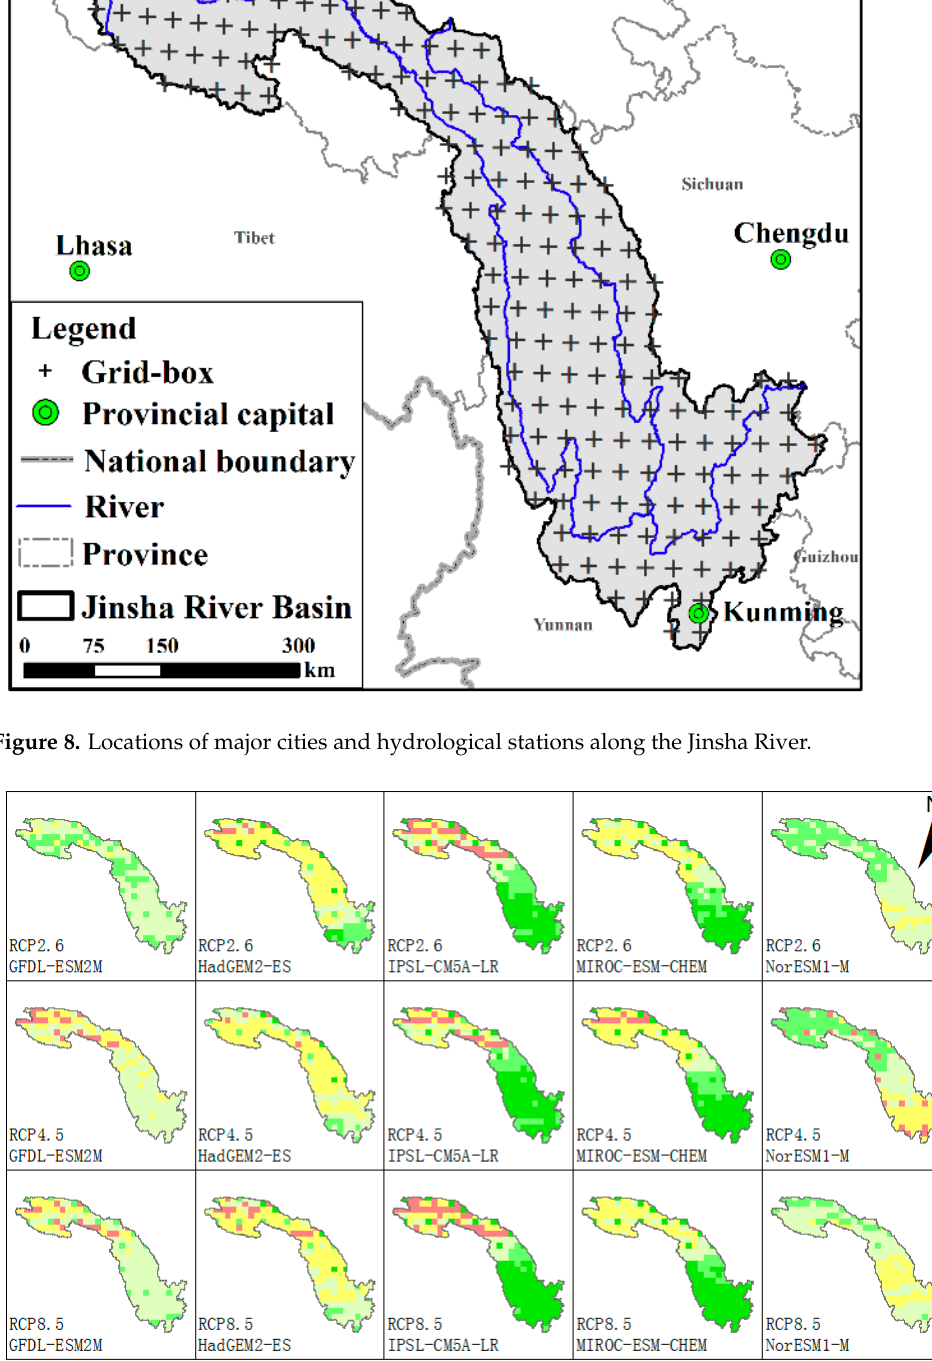
Figure 9. Change of